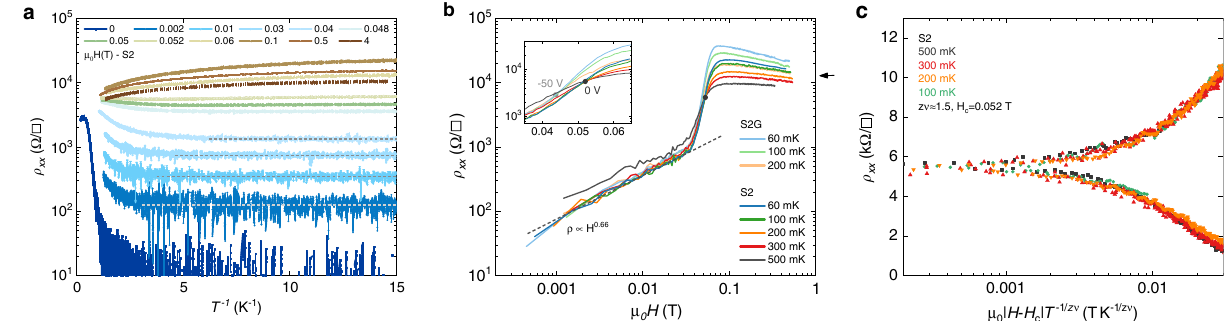
Fig. 2 Anomalous metallic phase and the avoided H-SIT. a Arrhenius plot of resistivity in various magnetic fi elds for sample S2. Robust resistivity saturation can be found in low magnetic fi eld at as high as 300 mK, indicated by dashed horizontal lines. b Log – log plot of magnetoresistance (MR) at different temperatures for S2 and S2G. In anomalous metallic phase between 0 and 0.04 T, resistivity is essentially temperature-independent below 300 mK. The data collapse into a single power law ρ ∝ H 0.66 , indicated by the dashed line. The arrow indicates resistivity of S2 at 4 T and 60 mK. (Inset) Expanded view of the same data between 0.035 and 0.065 T shows isotherm crossing points (solid circles) separating metallic from insulating behavior. c Scaling function for resistivity ρ ( ∣ H − H c ∣ T − 1/ z ν ) of S2 at 100, 200, 300, and 500 mK. The best data collapse occurs for z ν ≈